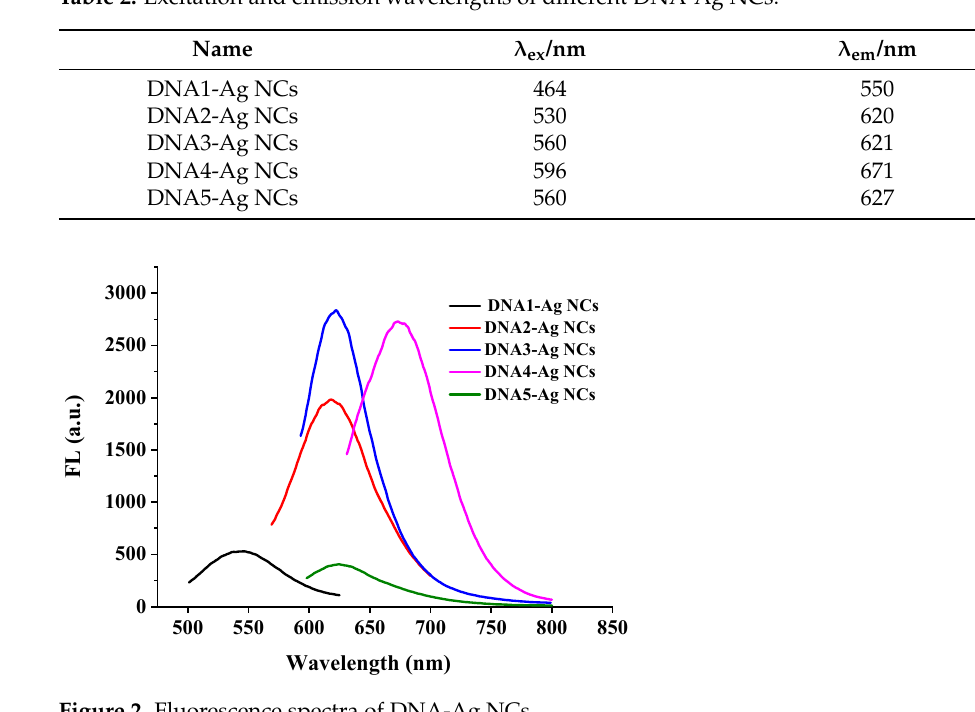
Figure 2. Fluorescence spectra of DNA-Ag NCs.